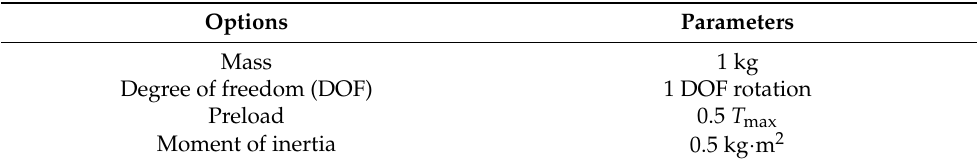
Table 1. Six DOF parameters settings.